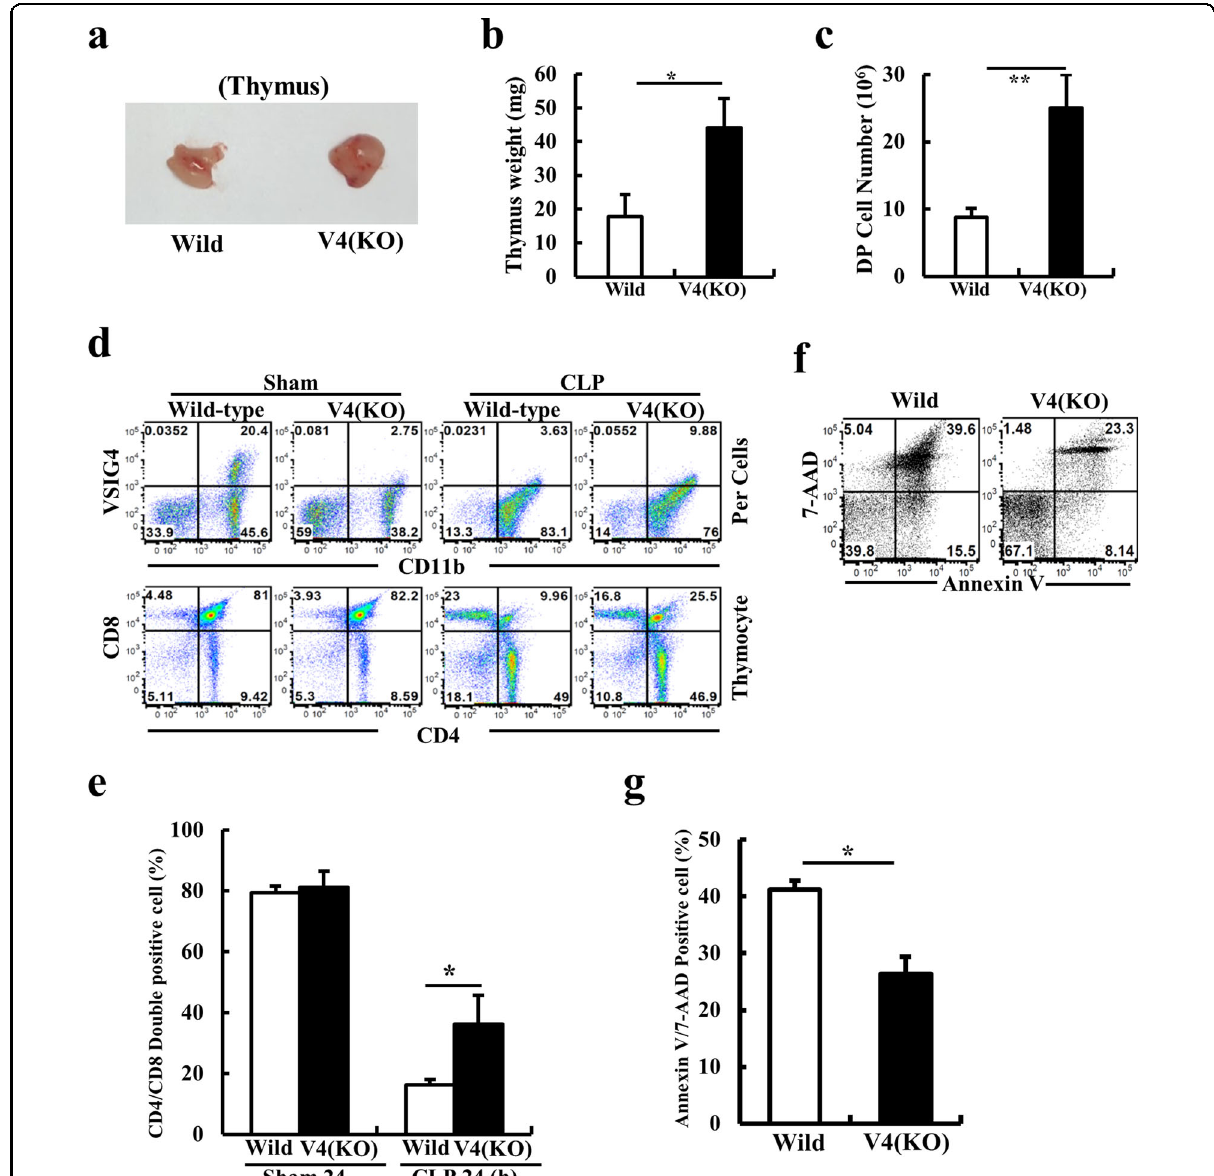
( a ), and stained with anti-VSIG4 and anti-CD11b antibodies to label peritoneal cells or anti-CD4 and anti-CD8 antibodies to label thymocytes. Then, the cells were analyzed by fl ow cytometry. e The percentage of DP thymocytes was estimated in total thymocytes from CLP-induced wild-type and V4(KO) mice. f Thymocytes from CLP-induced wild-type and V4(KO) mice cells were stained with 7-AAD and Annexin V. Thymocyte apoptosis was analyzed by fl ow cytometry. g Apoptotic cells in thymocytes were counted. The data represent the mean ± S.E.M. of three separate experiments. * p < 0.05, ** p < 0.01, ANOVA. V4(KO) indicates VSIG4-knockout mice and sham indicates sham-operated